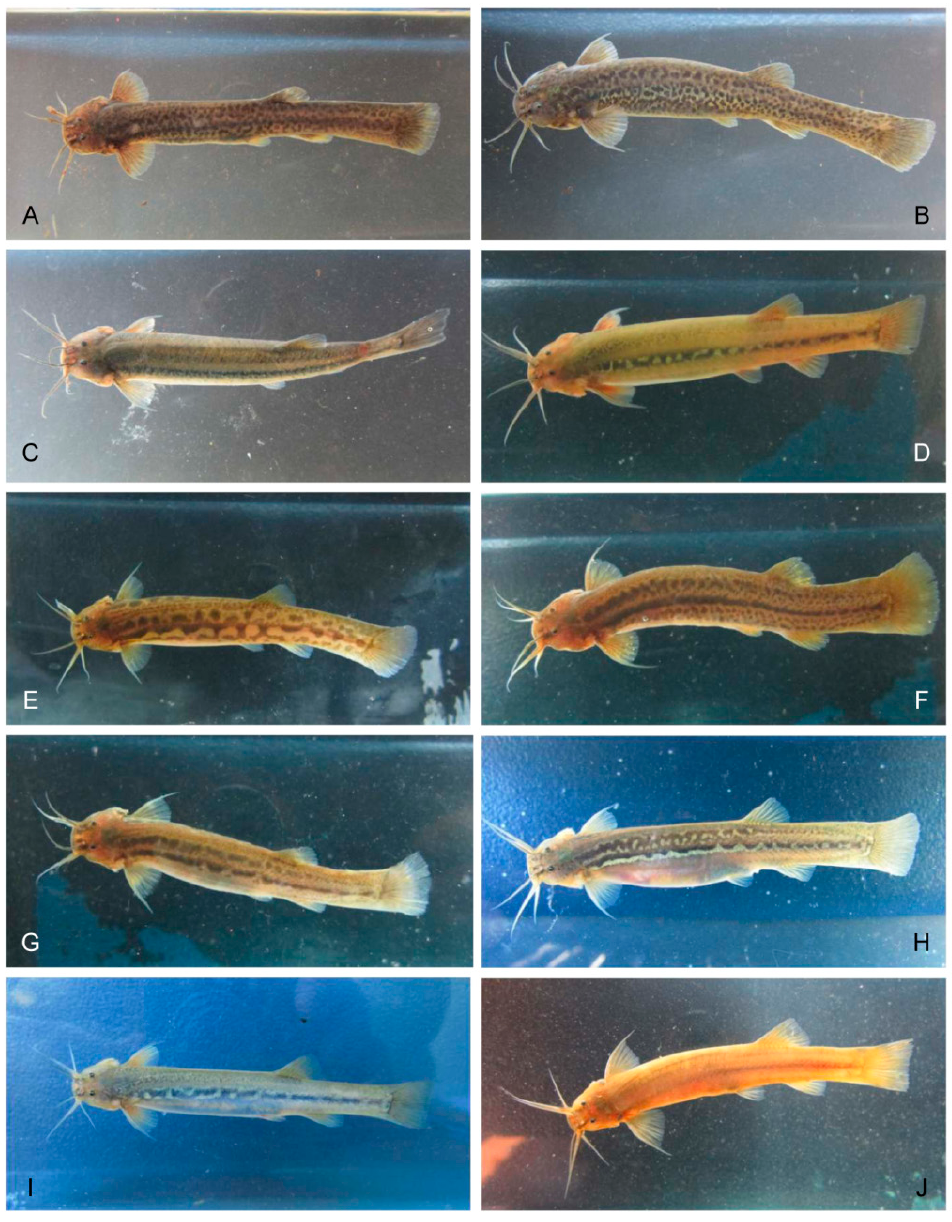
Figure 4. Species and morphotypes of genus Trichomycterus collected in the upper Madre de Dios River. ( A , B ) Trichomycterus sp.3 collected on Américo stream (21Q), ( C ) Trichomycterus sp.2 collected on Unión River (20R), ( D ) Trichomycterus sp.2 collected on San Pedro River (19R), ( E ) Trichomycterus sp.3 collected on Quitacalzon stream (17Q), ( F , G ) Trichomycterus sp.5 collected on Quitacalzon stream (17Q), ( H ) Trichomycterus sp.4 collected on Salvación River (12R), ( I ) Trichomycterus sp.6 collected on Kosñipata River (16R), and ( J ) Trichomycterus sp.1 collected on Queros River (13R).